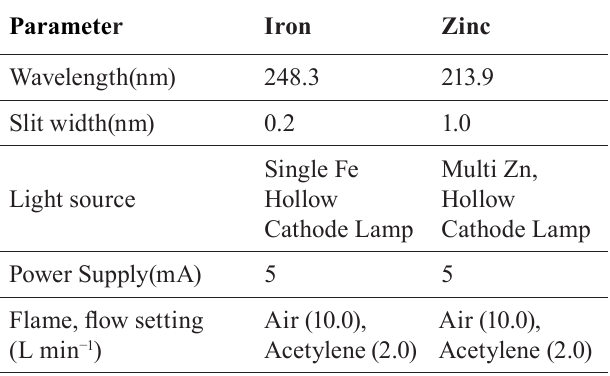
TABLE IV - FAAS instrumental parameters for the iron